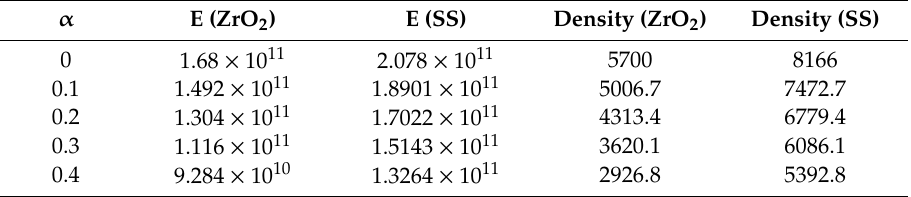
Figure 7. Variation in dimensionless natural frequency (DNF) for di ff erent volume fractions of porosity ( α ). Table 7. Young’s modulus and density of ZrO 2 and stainless steel (SS) at di ff erent α .